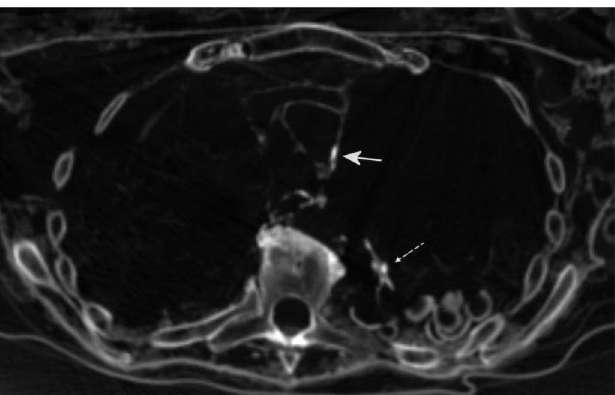
Fig 10. CT scan cross section through the thorax showing focal calcifications of the vessel wall (full arrow); note the peripheral pulmonary calcifications (dotted arrow) that occurs occasionally in this cut of the left lung. Additionally, the shell-like irregular objects are clearly visible.